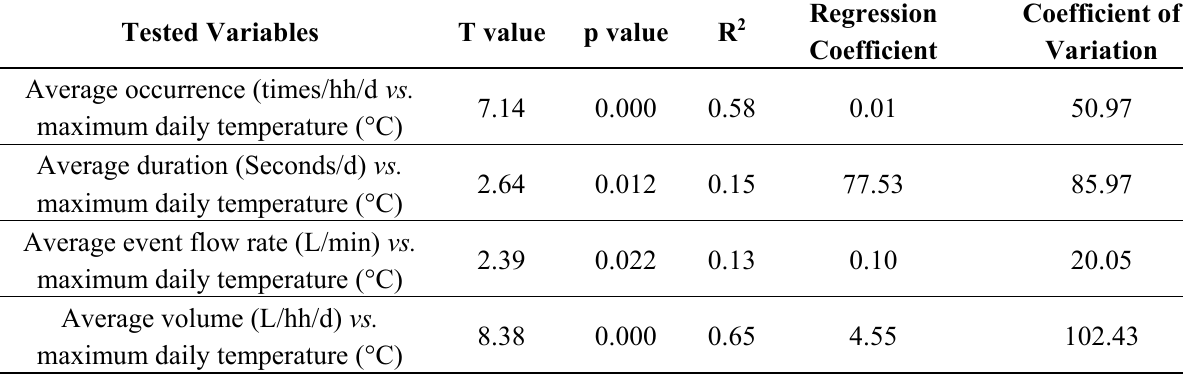
Table 8. Results of regression analysis between irrigation variables and maximum daily